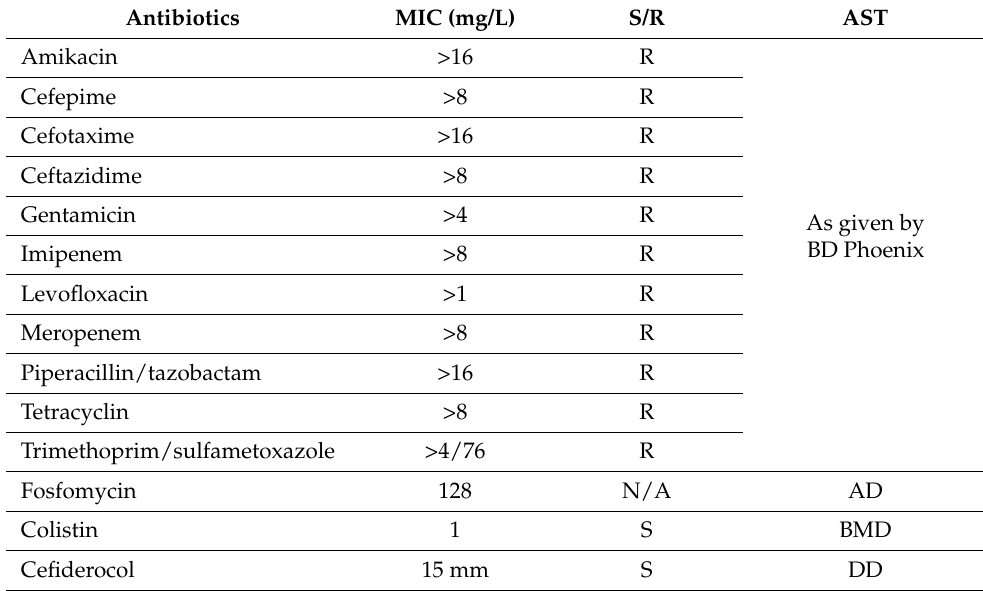
Table 3. Acinetobacter baumannii antibiotic susceptibility. MIC: minimum inhibitory concentration; S: susceptible; R: